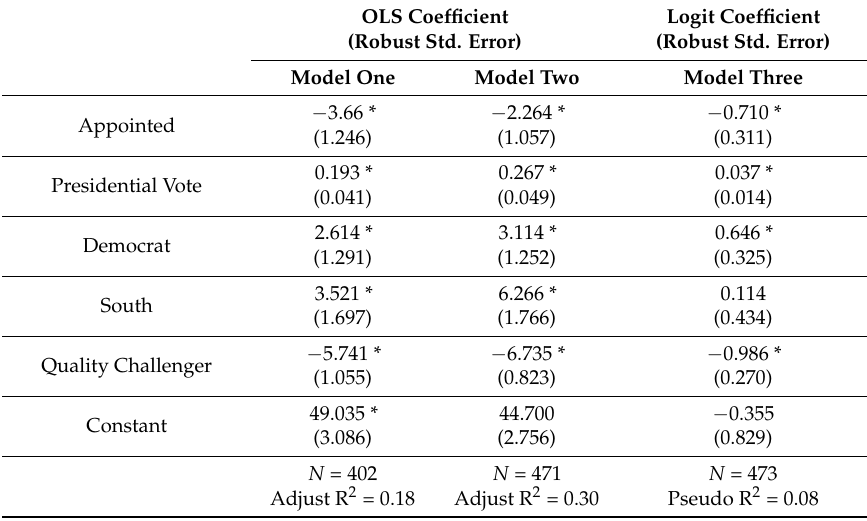
Table 4. Election Results